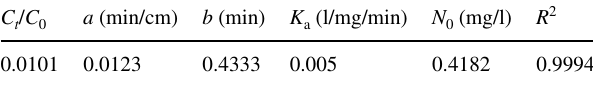
Table 4 Calculated constants of BDST model for the adsorption of fluoride by banana peel dust using linear regression analysis